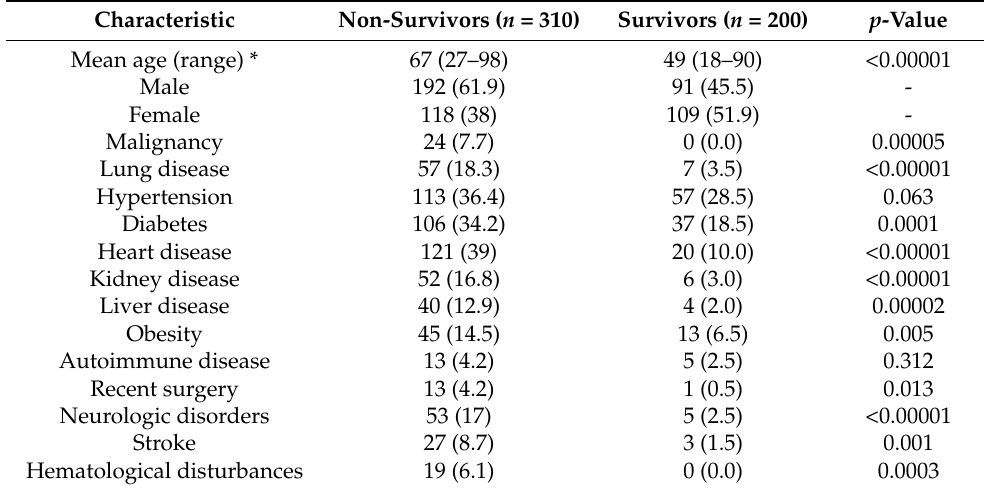
Table 1. Key characteristics of the development sample.